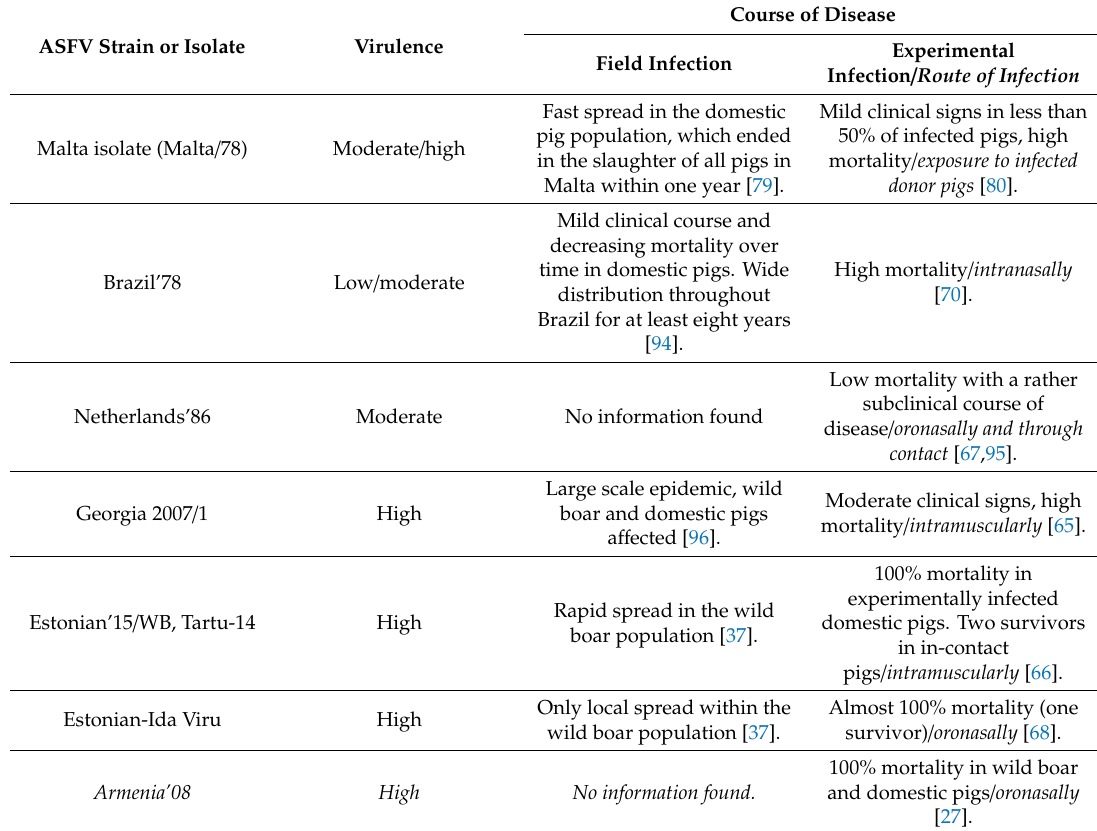
Table 1. Strains and isolates of African swine fever (ASF), their virulence, and course of field and experimental